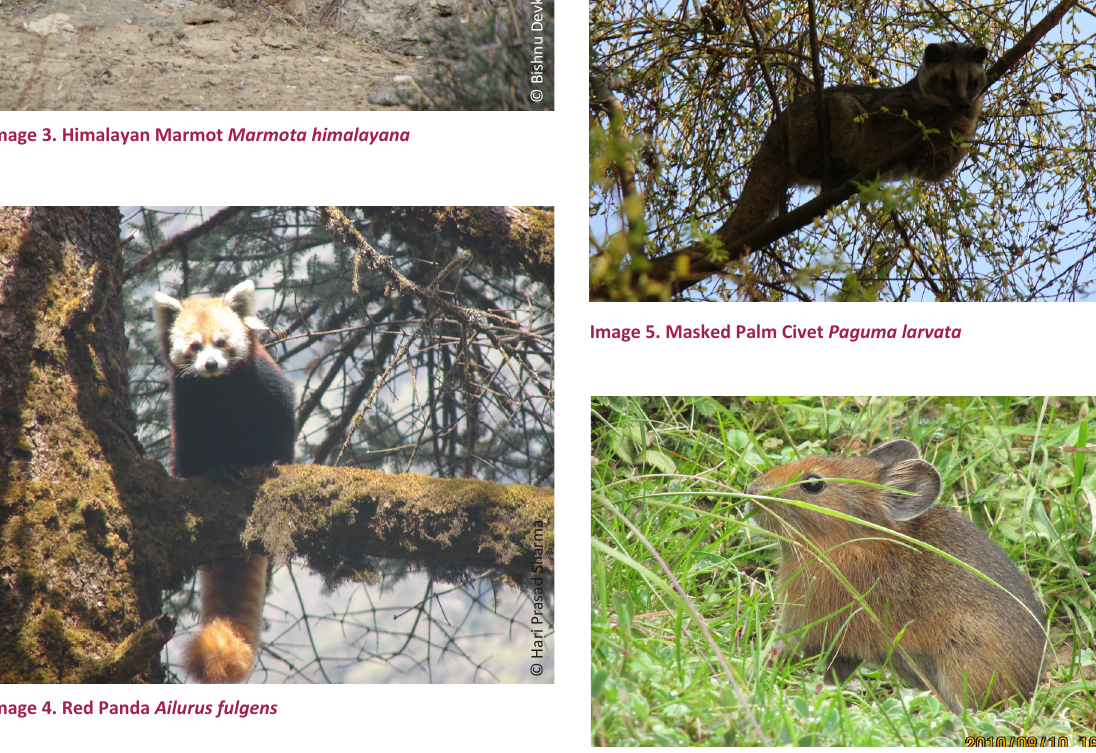
Image 6. Large-eared Pika Ochotona